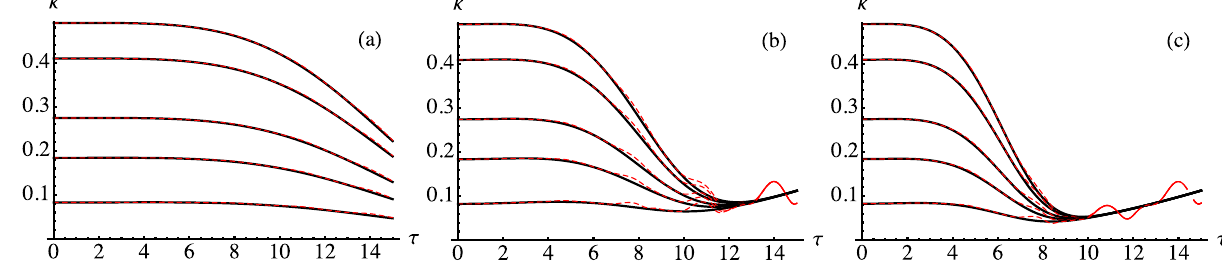
Figure 1. Comparison between the results obtained with and without the secular terms. The three panels show the symplectic eigenvalue κ as a function of the dimensionless time τ for different values of the other (dimensionless) parameters. The solid black curves denote results obtained with the secular approximation (i.e. dropping the secular terms) whereas the red dashed curves denote the full expression including the secular terms. In the left panel [panel ( a )] we show results for δ parameter r (from top to bottom r